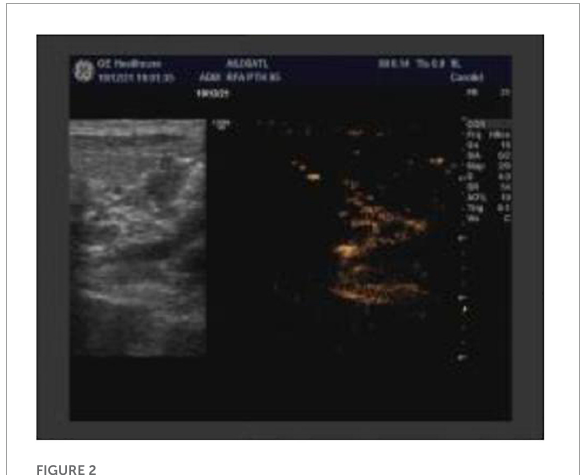
FIGURE2 B-ultrasound image after parathyroid radiofrequency